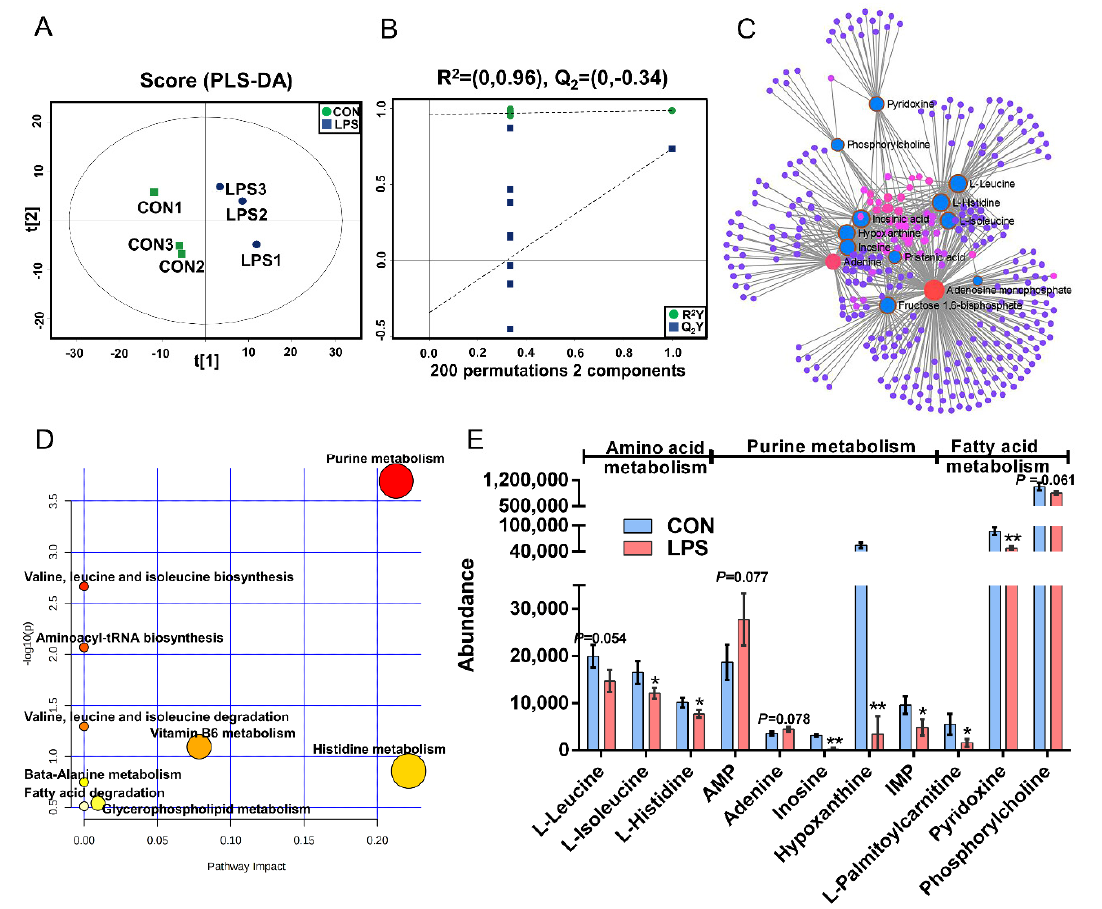
Figure 3. Metabolomics analysis of inflammation response in MAC-T. ( A ). The PLS-DA score plot of the LPS vs. CON group. ( B ). Cross-validation plot of the PLS-DA model with 200 permutation tests in the comparative group of LPS vs. CON; ( C ). Metabolite-metabolite interaction network of DMs in the comparative group of LPS vs. CON. Node size represents the degree. Red and blue circles correspond to the increased and reduced DMs in the LPS vs. CON group, respectively. ( D ). Pathway analysis of DMs in the LPS and CON groups. The X -axis and Y -axis indicate the pathway impact and the degree of pathway enrichment, respectively. A darker color indicates a higher degree of pathway enrichment, and a larger size indicates a higher pathway impact value. ( E ). The classification map of DMs and pathways. * p < 0.05 and ** p < 0.01, represent the difference between LPS and CON group; DMs: differential metabolites.